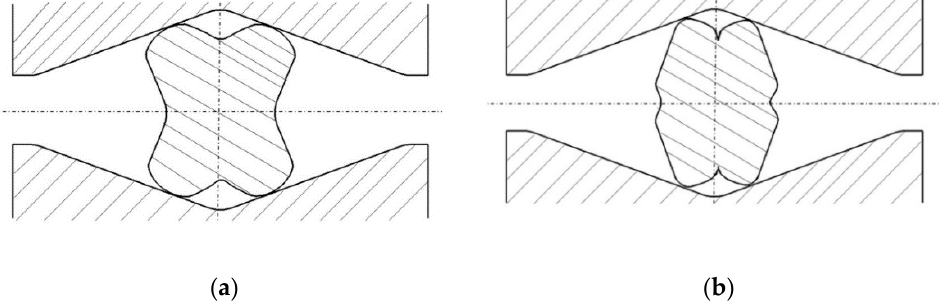
Figure 6. Order of forging the workpiece with a concave cross-section with V-shaped anvils ( a ) after the first pass, ( b ) after the second pass.